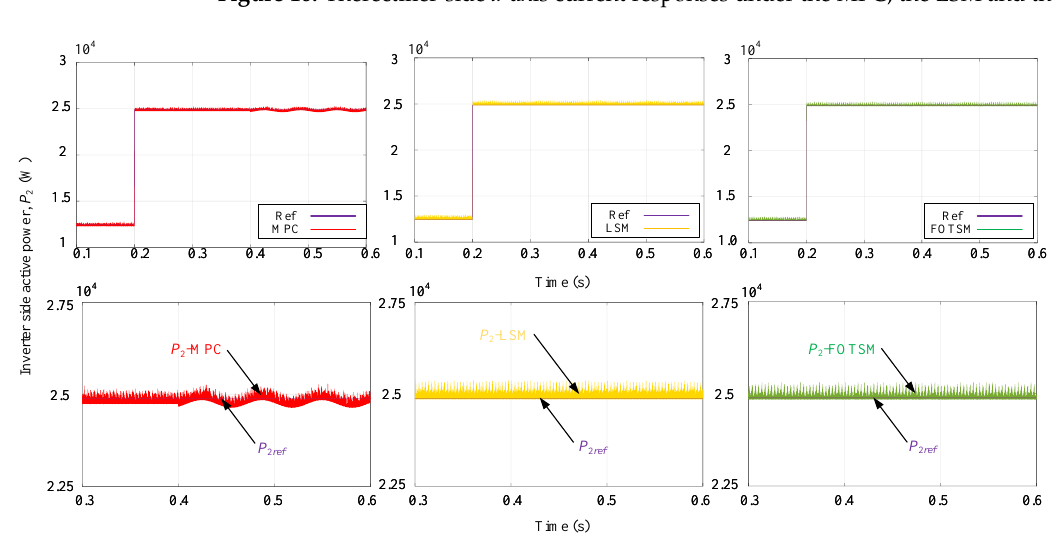
Figure 11. The load grid active responses under the MPC, the LSM and the FOTSM.